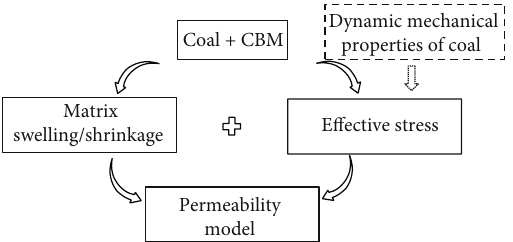
Figure 1: Conceptual graph of gas-solid coupling paths of coal and